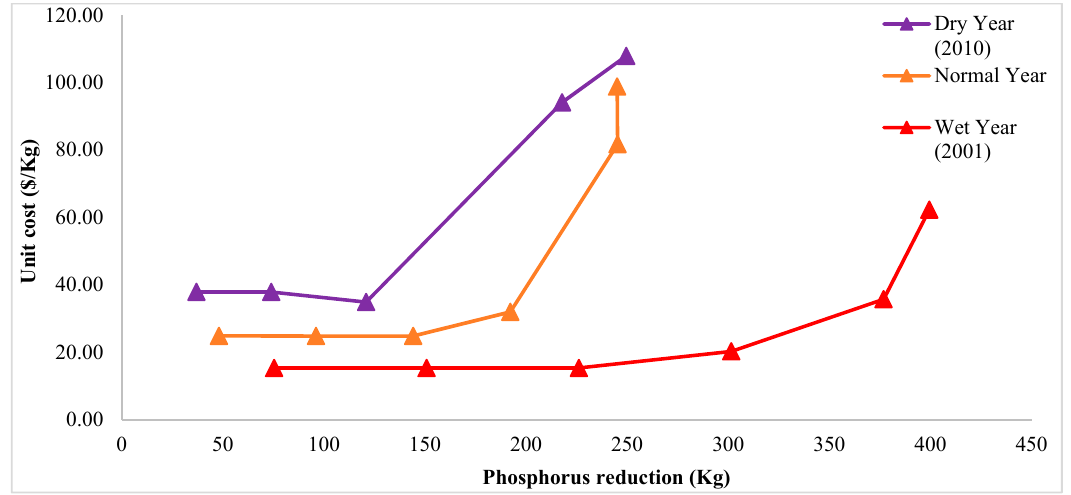
Figure 3. Per unit cost of phosphorus reduction using different best management practices in the Saline Bayou Watershed.